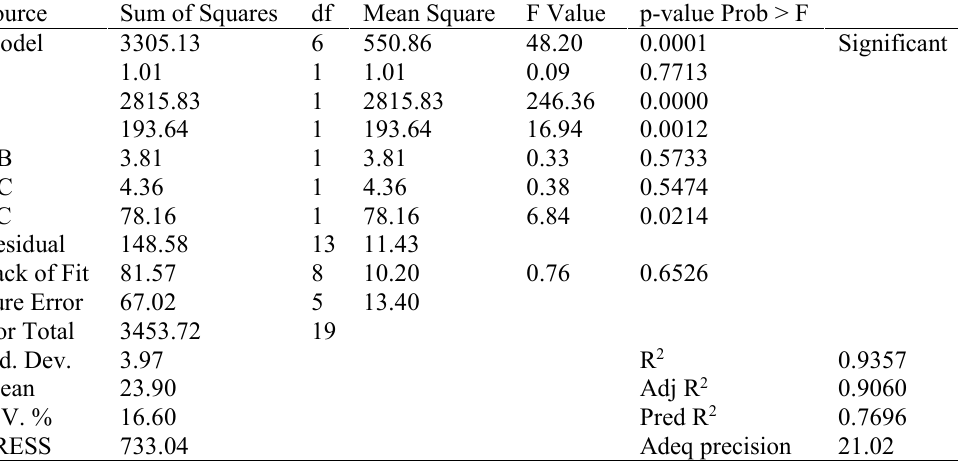
Table 6. Quadratic model of ANOVA for Cl − ion removal efficiency in ED process Source